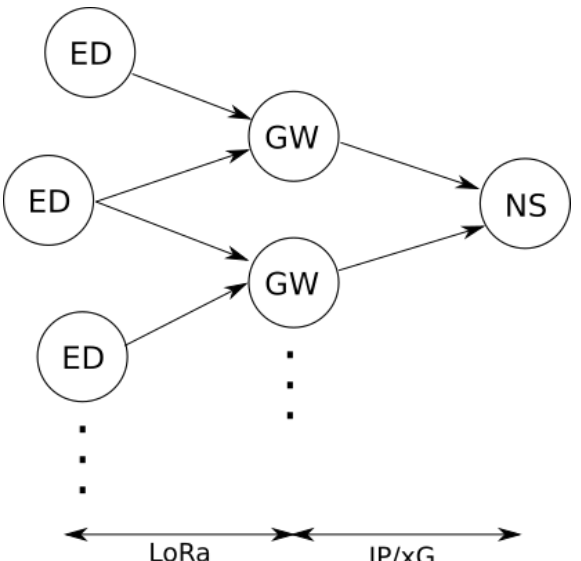
Figure 1. LoRaWAN topology